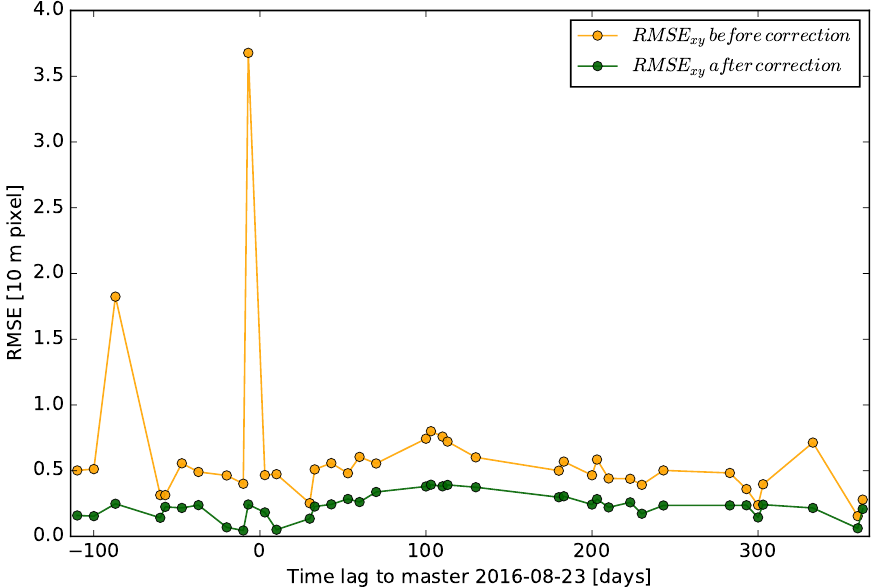
Figure 6. Co-registration RMSE xy before and after corrections as a function of the time lag between the master image (31TGK, 23 August 2016) and the slave images.